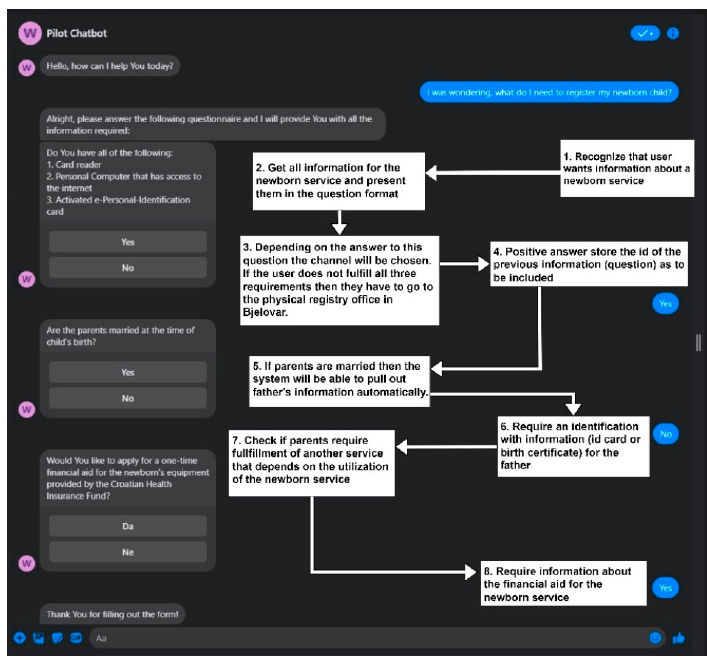
Figure 7. Chatbot dialogue excerpt for the “Newborn PS”.